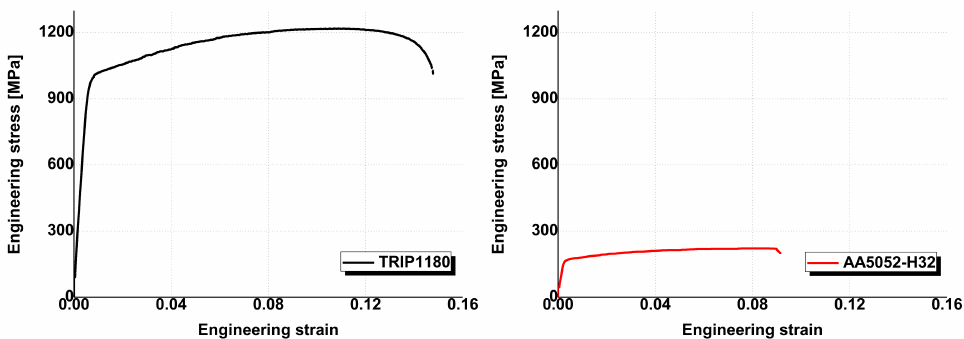
Figure 5. Stress–strain curves at the quasi-static state for TRIP1180 and AA5052.